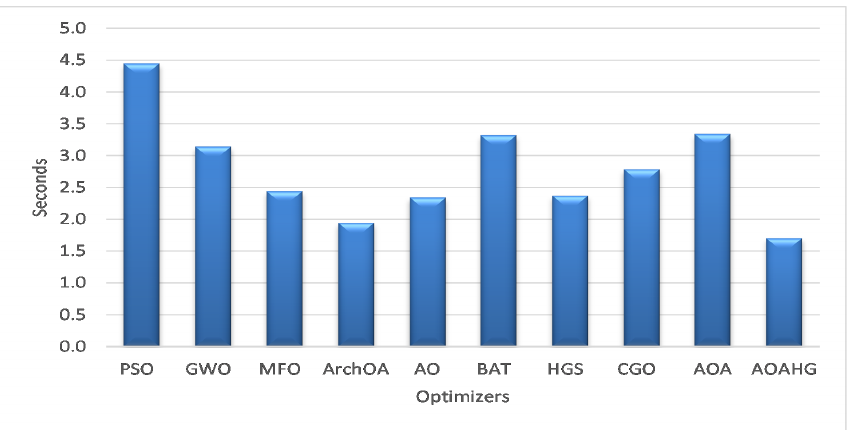
Figure 7. Average execution times of the SVM across the datasets.